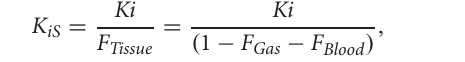
Frontiers in Physiology |